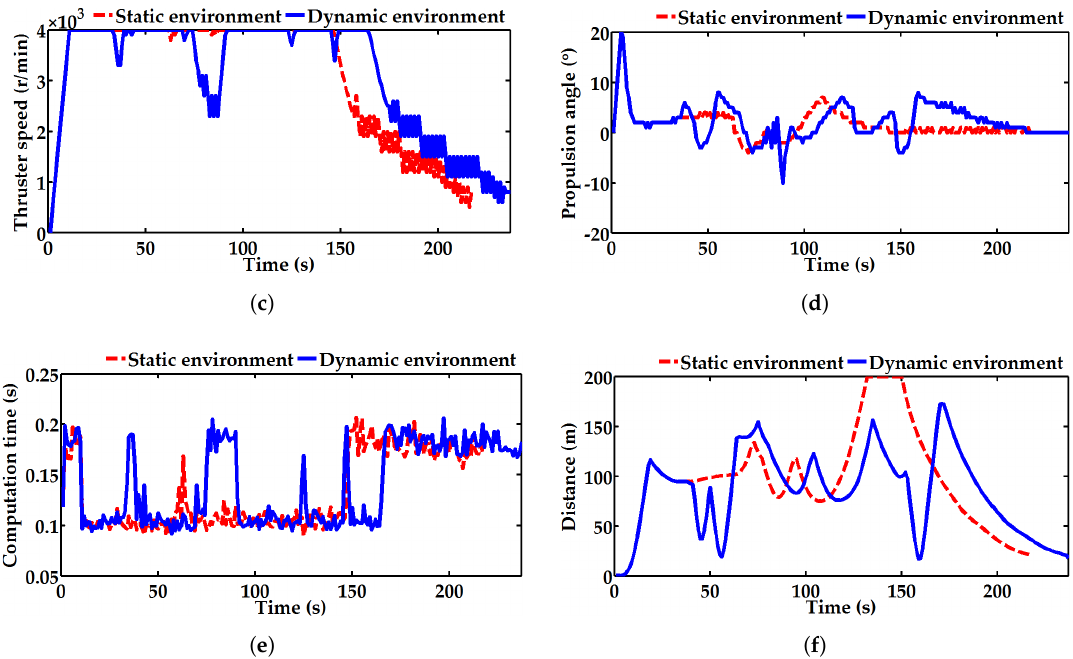
Figure 14. Evaluation results in a real environment. ( a ) Speed of the USV; ( b ) course of the USV; ( c ) thruster speed; ( d ) command propulsion angle; ( e ) computation time; ( f ) distance between the USV and the collision